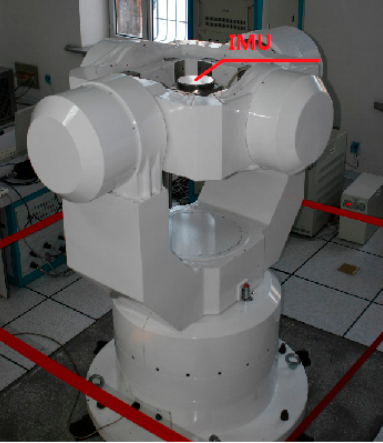
Figure 7. Three-axis turntable for experiments.